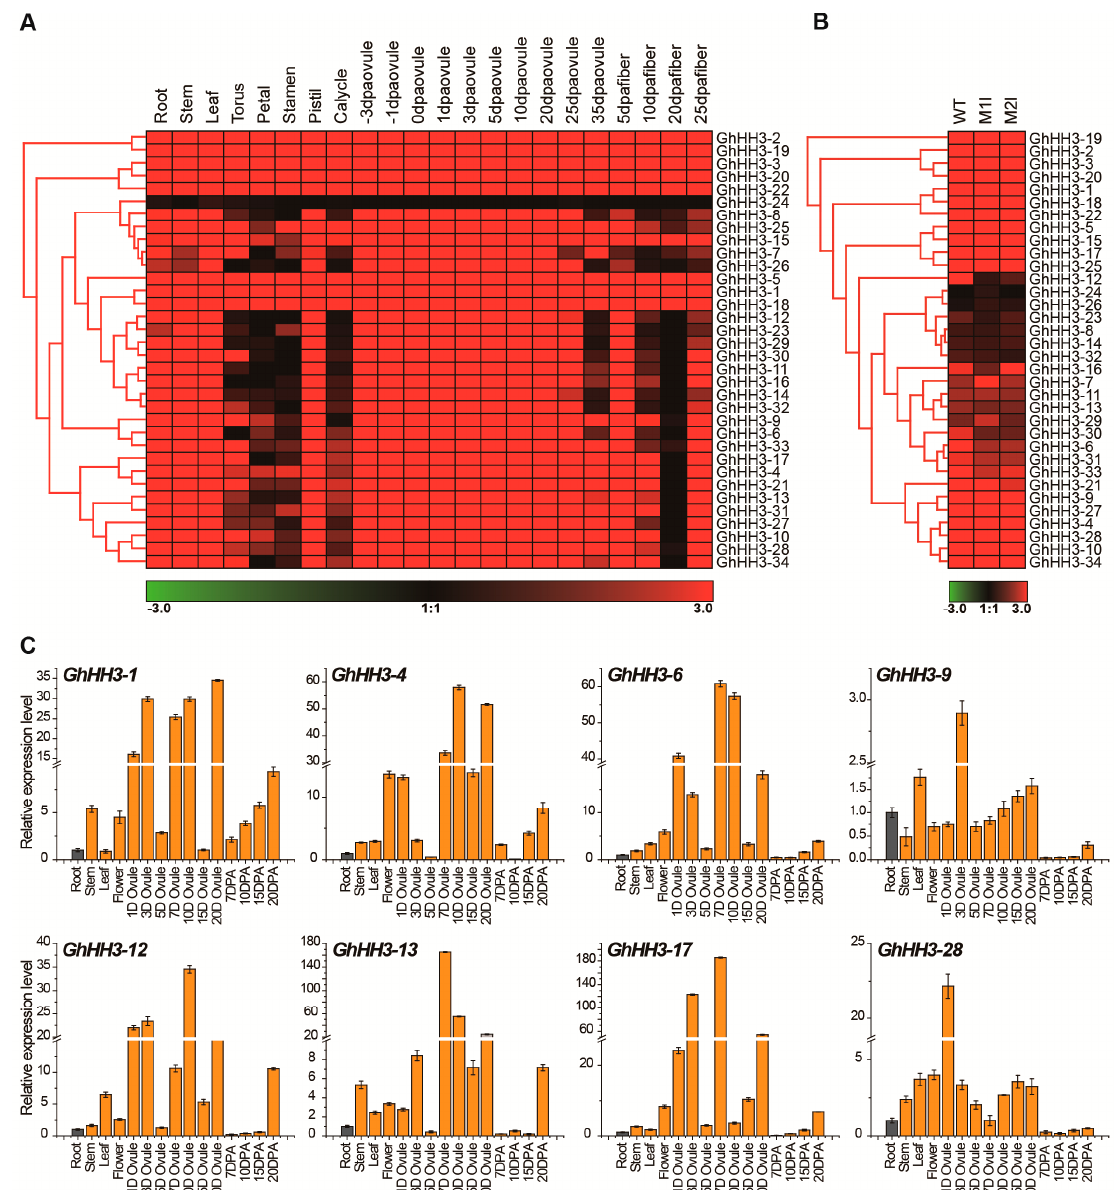
Figure 4. Tissue specific expression patterns analysis of GhHH3 genes in di ff erent tissues of the plant. ( A ) Heat map generated for the expression of 34 GhHH3 genes in 22 di ff erent tissues. Data obtained from publically available transcriptomic data and the color bar (down) indicate the values of expression level. ( B ) Heat map of all GhHH3 relative expressions in two fuzzless / lintless mutants ( M1l and M2l ) as compared with wild type (WT) plants. Data were extracted from published RNA-seq data and the color bar (down) indicates the expression level. ( C ) Relative expression level of eight selected GhHH3 genes in di ff erent tissue estimated by qRT-PCR analysis. Error bars indicate the standard deviations (SD) of three independent biological repeats.